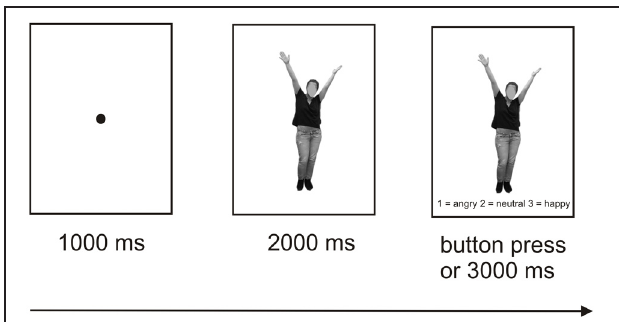
FIGURE 3 | Schematic illustration of the experimental design.